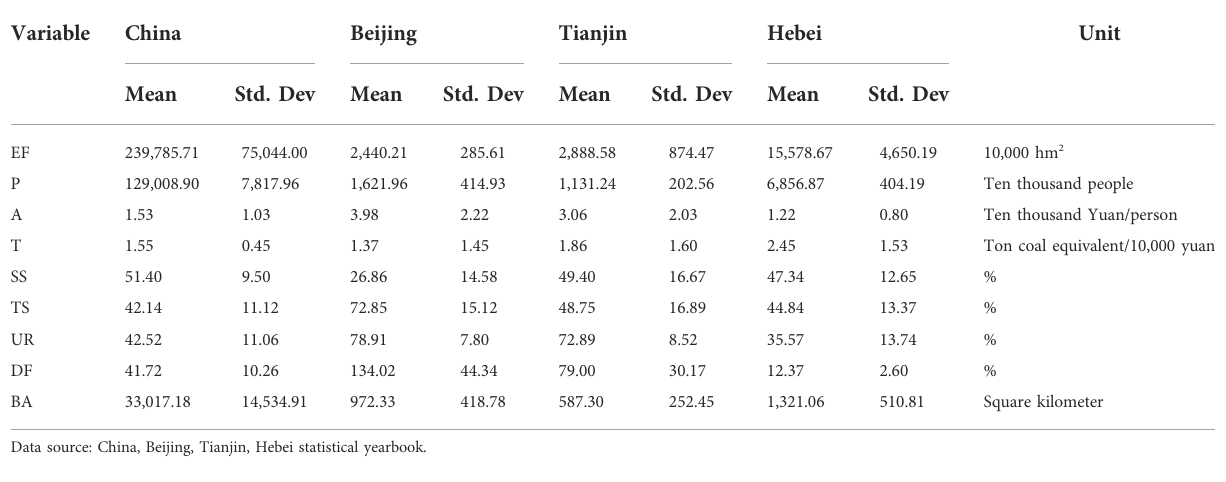
TABLE 2 The statistical description of variables.